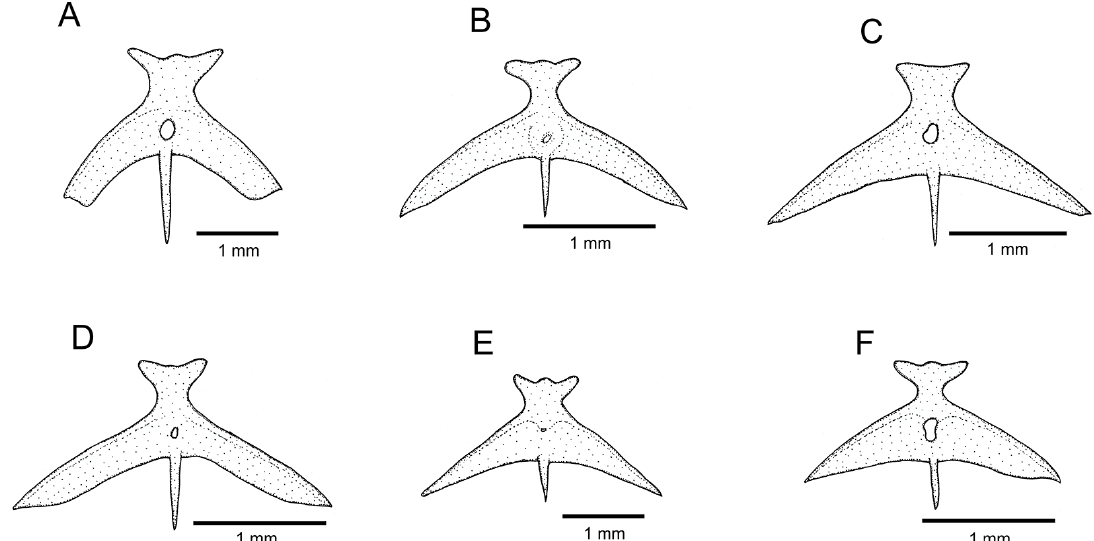
Figure 7. Parurohyal, in ventral view, of ( A ) Trichomycterus (Cryptocambeva) garbei Costa, Azevedo- Santos & Ka tz sp. nov.; ( B ) Trichomycterus (Cryptocambeva) listruroides Costa, Ka tz & Azevedo-Santos sp. nov.; ( C ) Trichomycterus (Cryptocambeva) saturatus Costa, Ka tz & Azevedo-Santos sp. nov.; ( D